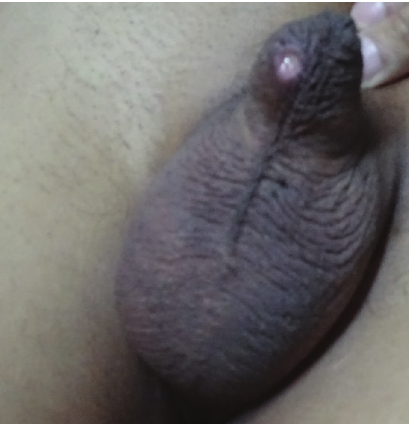
Figure 1: Ulcer in the ventral surface of the shaft of the penis.